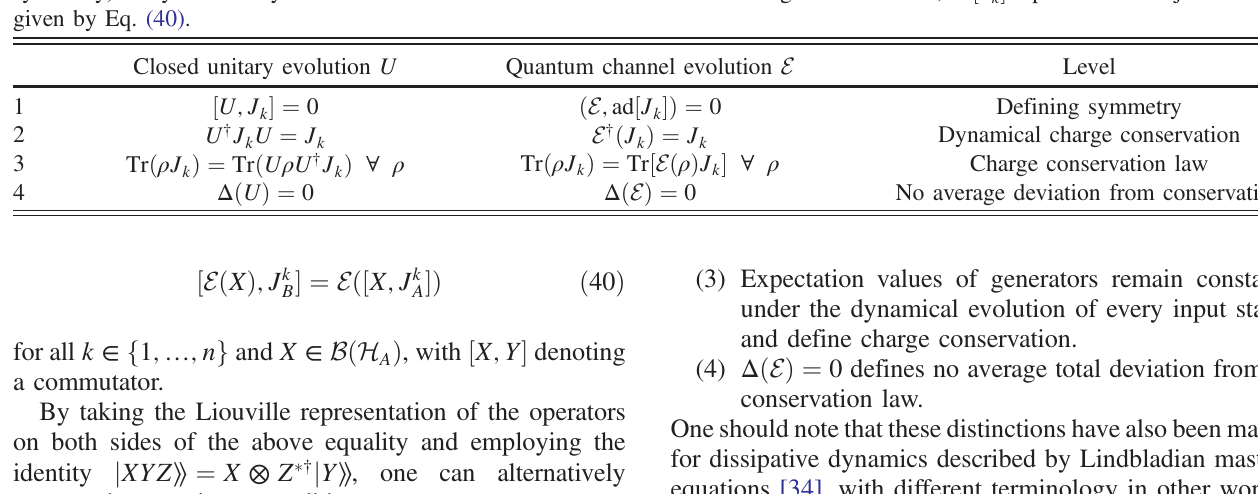
represents the adjoint action k (cid:2)